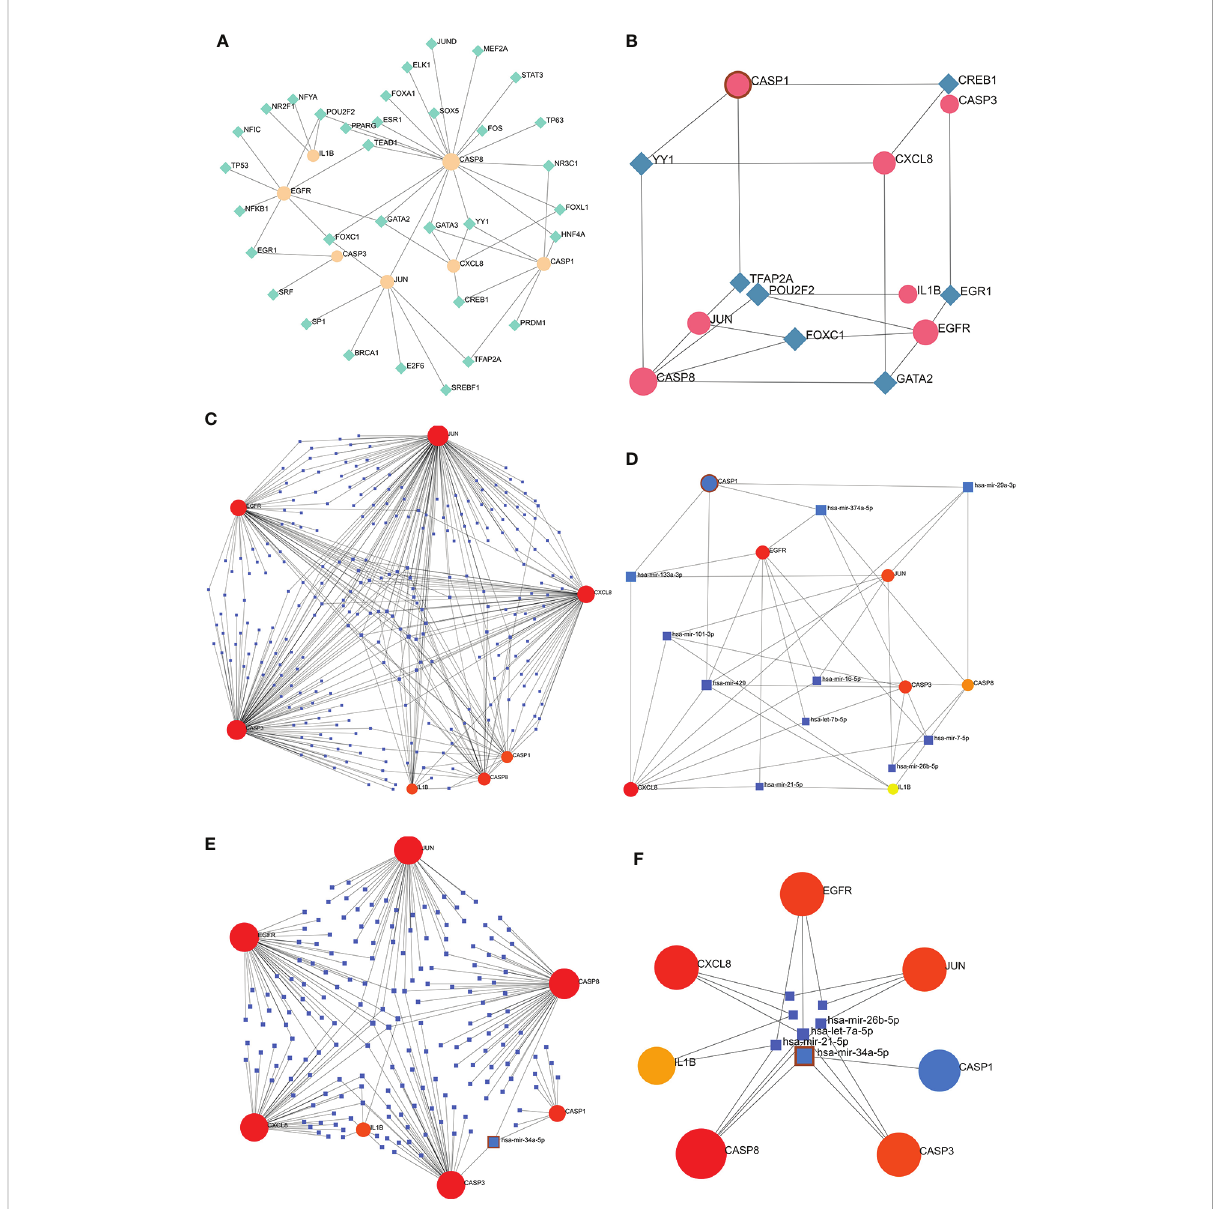
FIGURE 10 TF-hub genes and miRNA-hub genes network construction using NetworkAnalyst. (A, B) TF-hub genes network and simpli fi ed diagram. Circles were genes, while squares were TFs. (C, D) miRNA-hub genes network and simpli fi ed diagram (TarBase version 8.0). Circles represent genes, while squares are miRNAs. (E, F) miRNA-hub genes network and simpli fi ed diagram (miRTarBase v8.0). Circles represent genes, while squares are